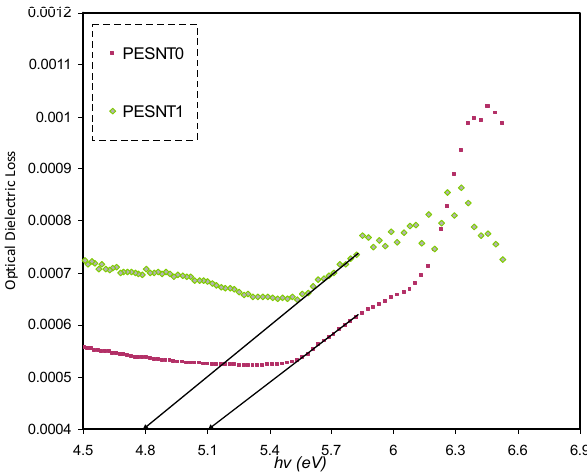
Figure 6. Optical ε i spectra of pure PEO (PESNT 0) and PESNT 1 films.